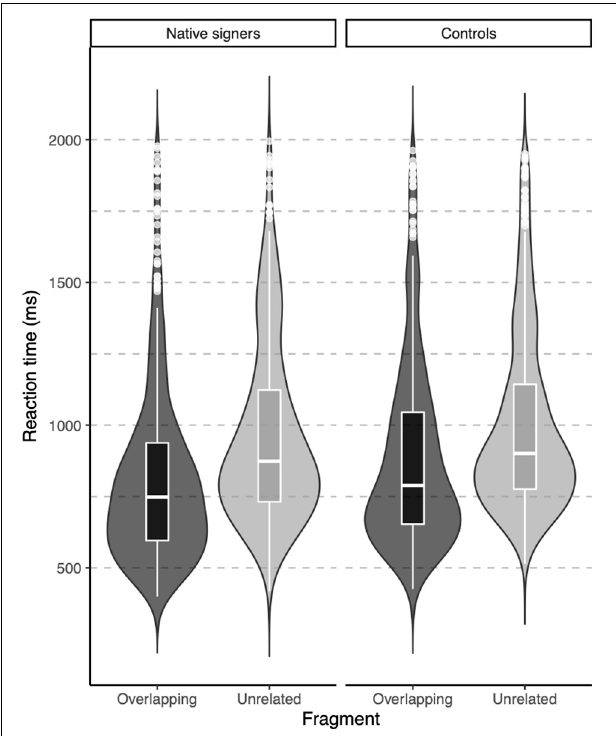
FIGURE 4 | Violin-boxplots depicting reaction times (in ms) for correct responses in Native signers only, for Ambiguous (left) and Unambiguous (right)